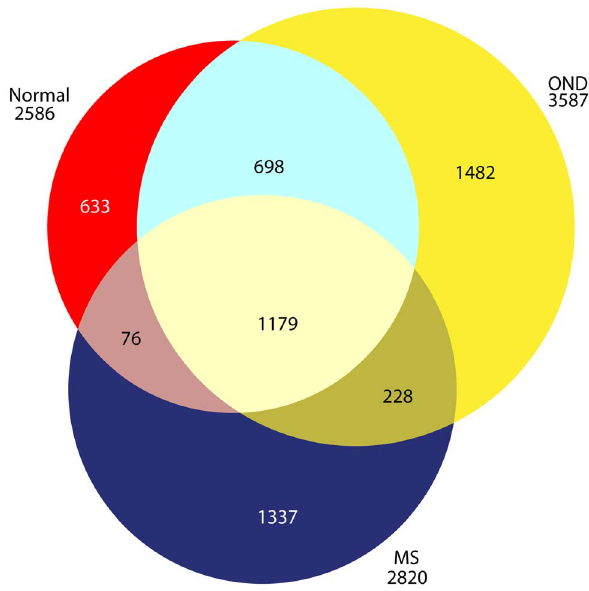
Figure 1. In-depth off-line 2D-LC- MS/MS analysis of the CSF proteome of a pooled sample composed of CSF from all MS patients resulted in the identification of 2820 proteins, and the comparison to previous results obtained from analyses of healthy normals [8] and other neurologic disease (OND) [9].